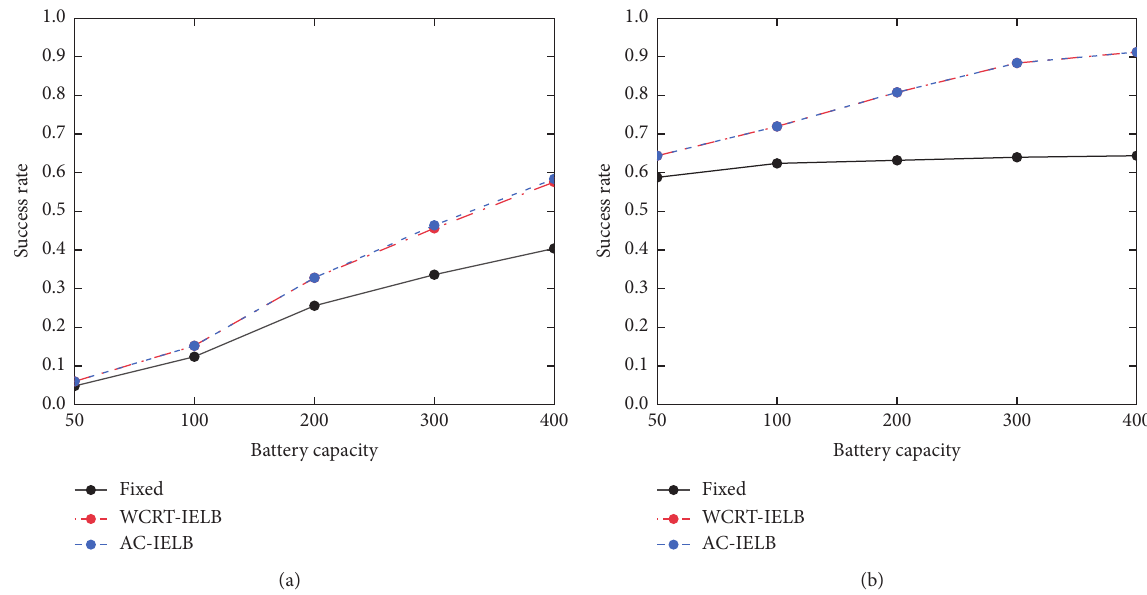
Figure 6: The success rate of 250 experiments. (a) ALAP scheduling algorithm. (b) ASAP scheduling